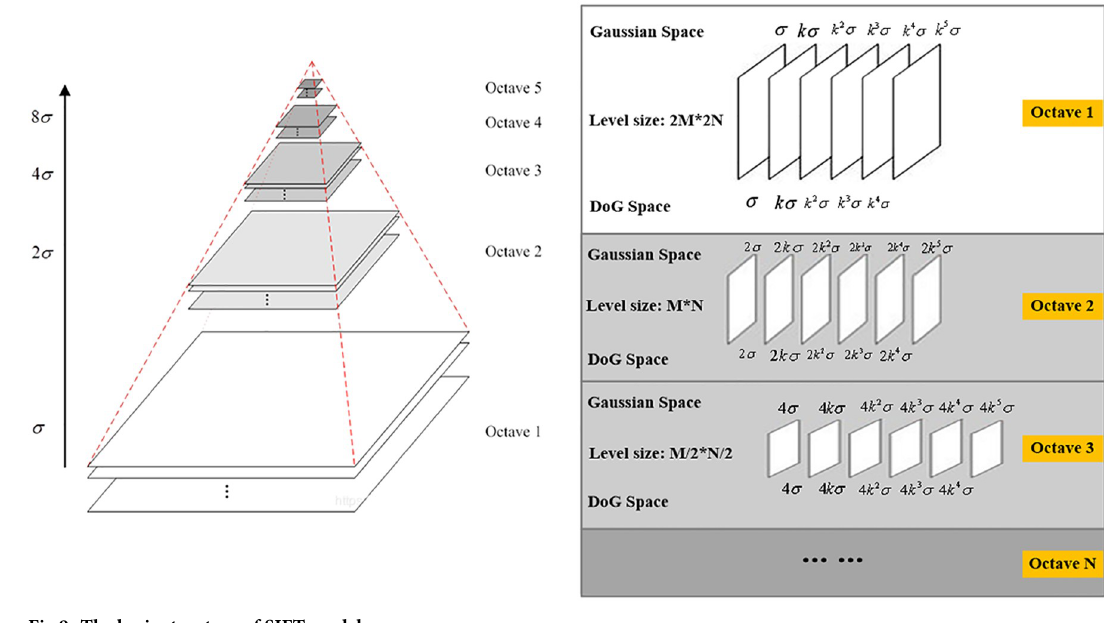
Fig 9. The basic structure of SIFT